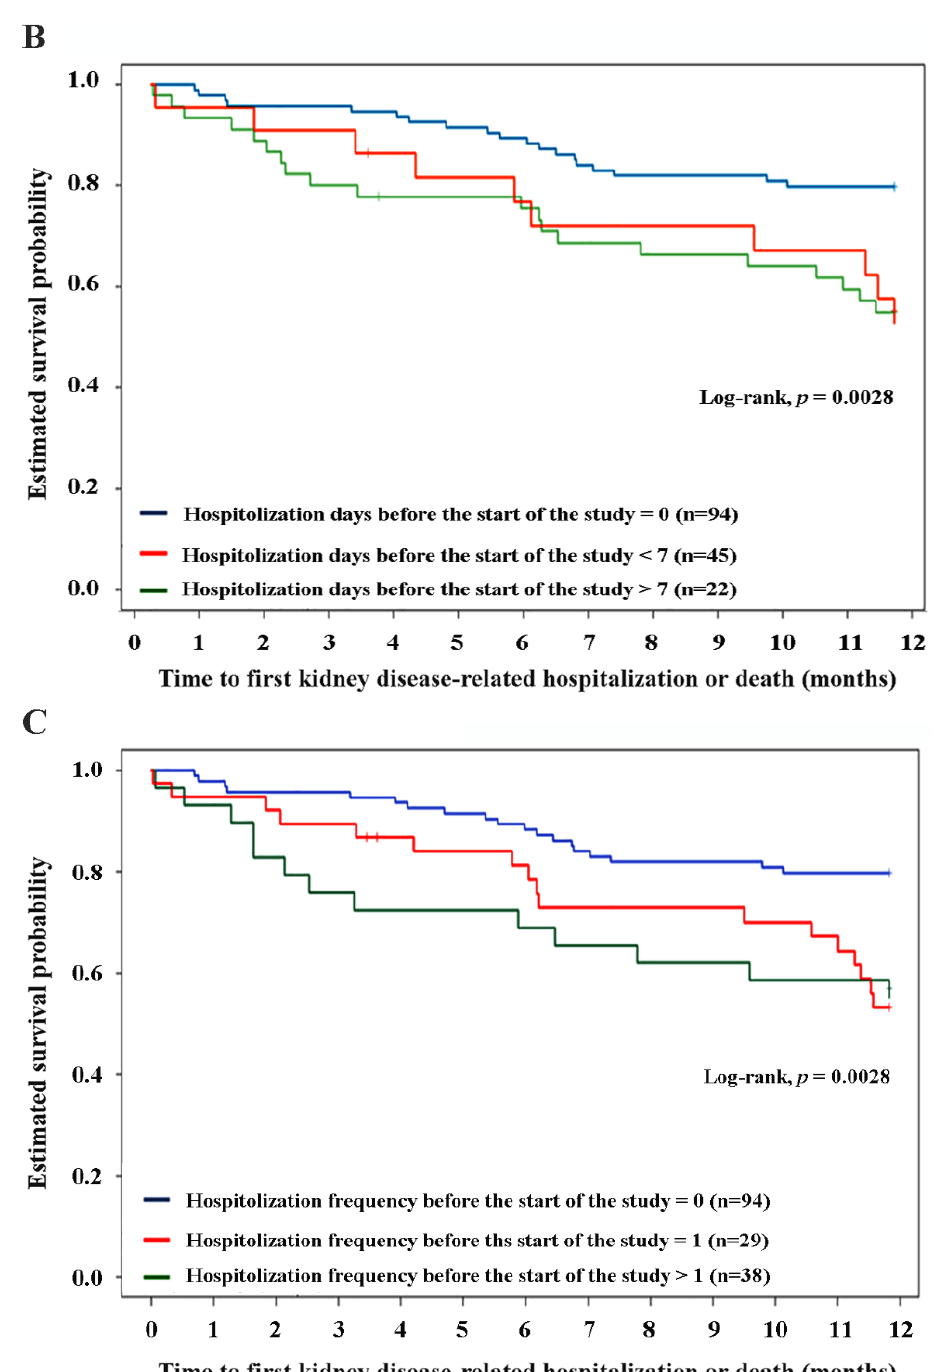
Figure 3. Kaplan−Meier estimate of the survival curve for time to the first kidney disease-related hospitalization or death stratified by ( A ) all-cause hospitalization frequency, ( B ) all-cause hospitalization days, and ( C ) kidney disease-related hospitalization frequency. ( A – C ): Hospitalizations were all within one year before the start of the study.